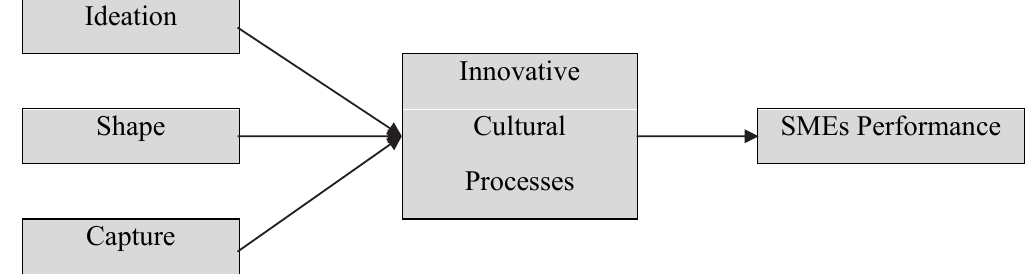
Fig. 1. The framework of the proposed study of this